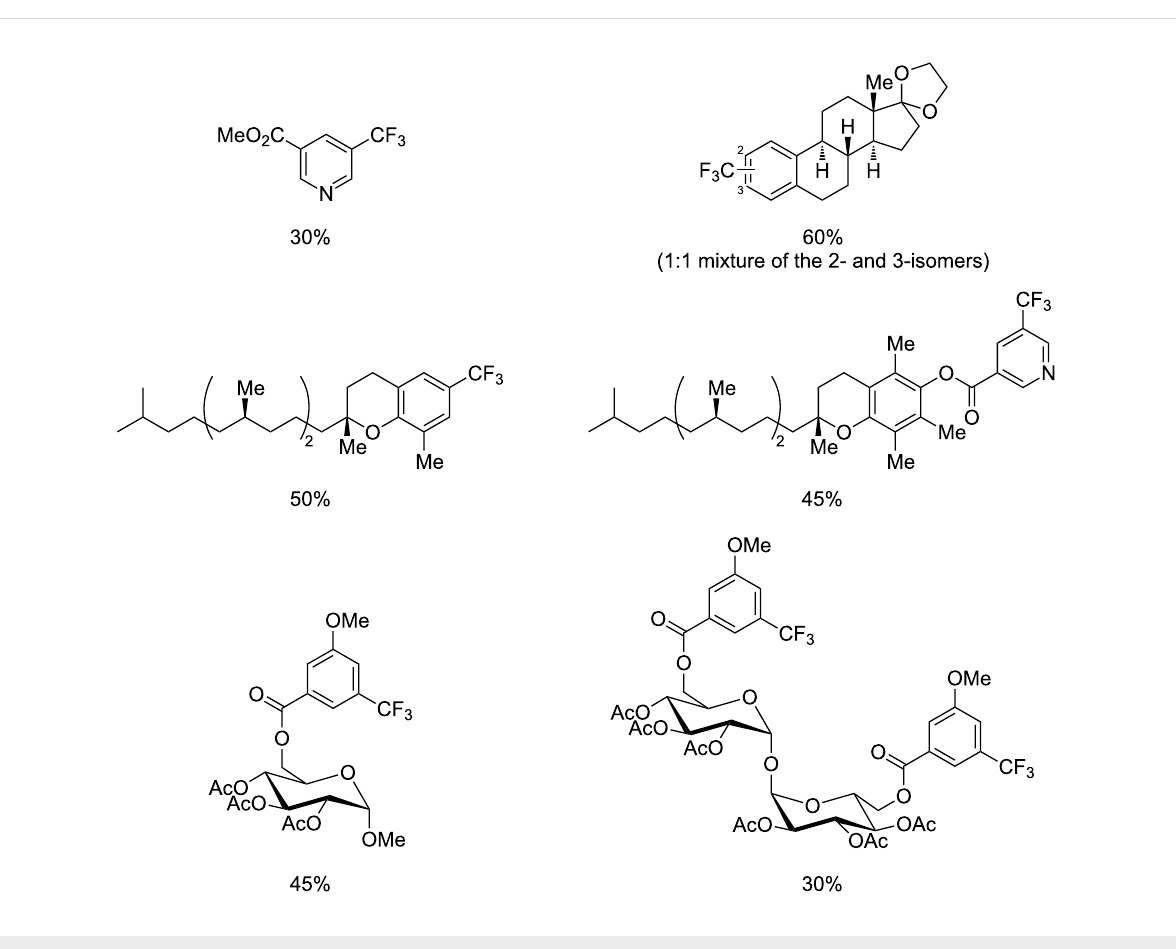
Figure 18: One-pot Ir-catalyzed borylation/Cu-catalyzed trifluoromethylation of complex small molecules by Q. Shen et al. [37].